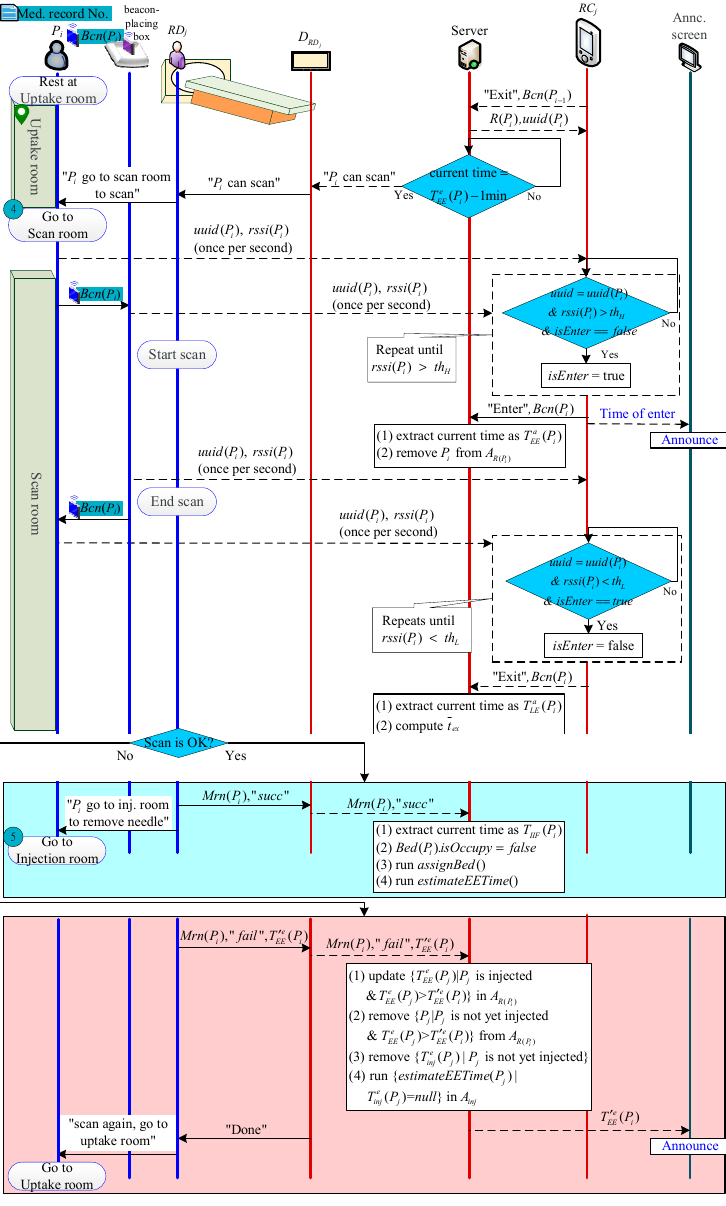
Figure 8. Examination process.